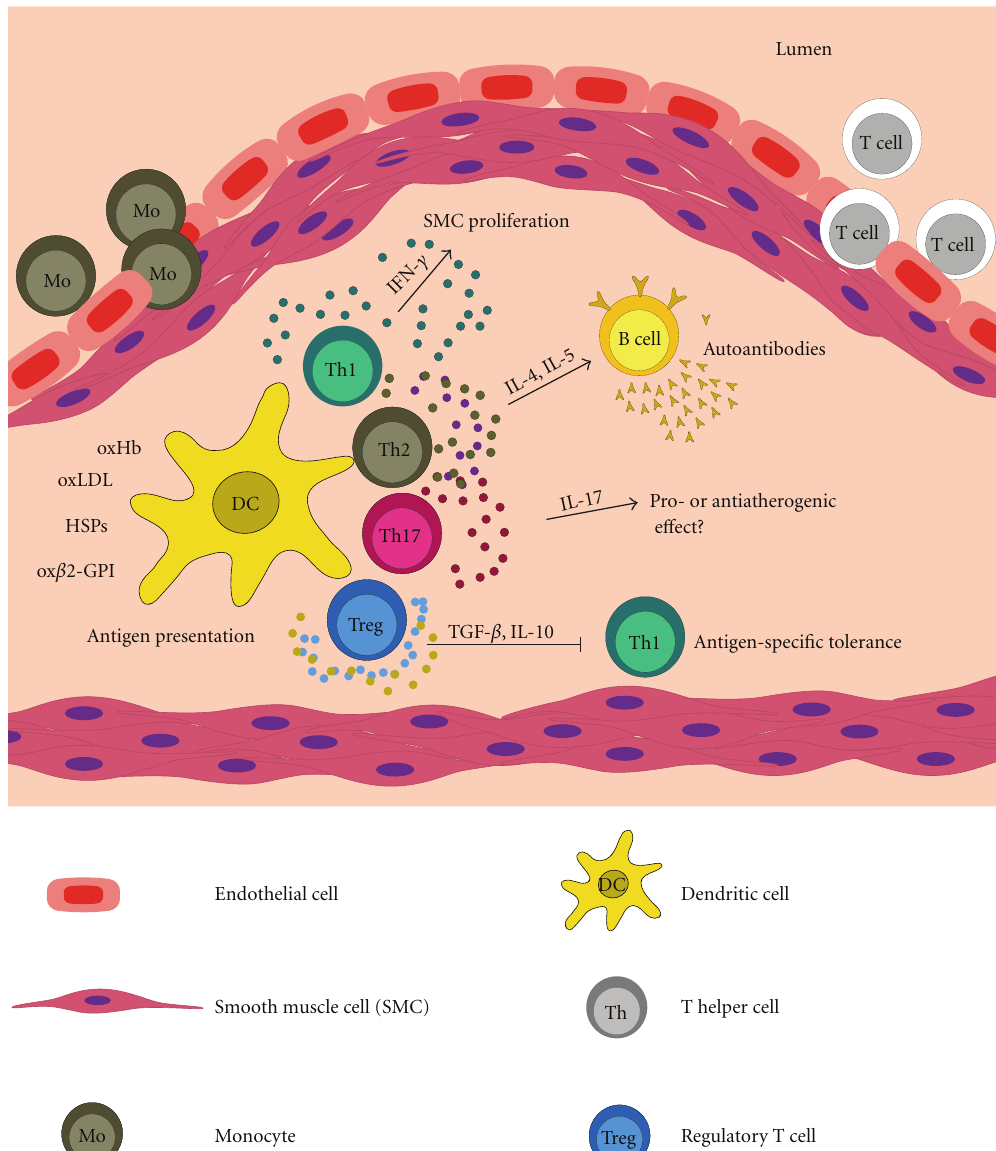
Figure 1: Schematic representation of T lymphocyte subset activation within atherosclerotic plaque. Di ff erent self-structures are expressed in the intima of the vessel wall and subjected to enzymatic/oxidative modifications. These modified molecules are taken up by dendritic cells and presented to CD4+ T helper cells via MHC class II molecules. Antigen presentation promotes T lymphocyte activation and secretion of di ff erent cytokines. E ff ector CD4+ Th1 cells produce pro-inflammatory cytokines, particularly IFN- γ , with proatherogenic e ff ects. Activated Th2 lymphocytes secrete IL-4 and IL-5 which promote the di ff erentiation of B cells in plasma cells and the production of specific antibodies. Some infiltrated T cells upon activation di ff erentiate in Th17 lymphocytes characterized by the production of IL-17, but their role remains controversial. Regulatory T cells (Tregs) downregulate inflammation by secretion of TGF- β and IL-10. The pro-inflammatory mediators released by activated T cells reduce the stability of the lesion promoting plaque rupture and thrombotic events.